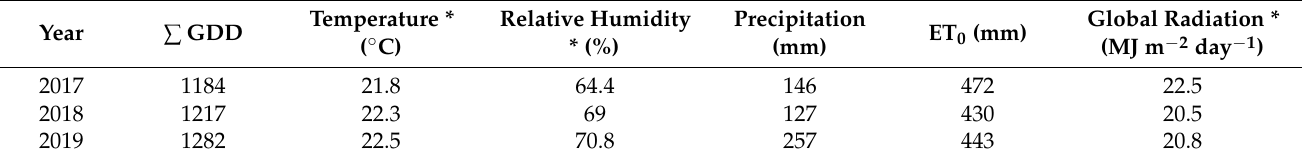
Table 3. Climate-related parameters by the three different years in the growing season. ET 0 refers to the reference evapotranspiration (computed by the FAO Penman–Monteith